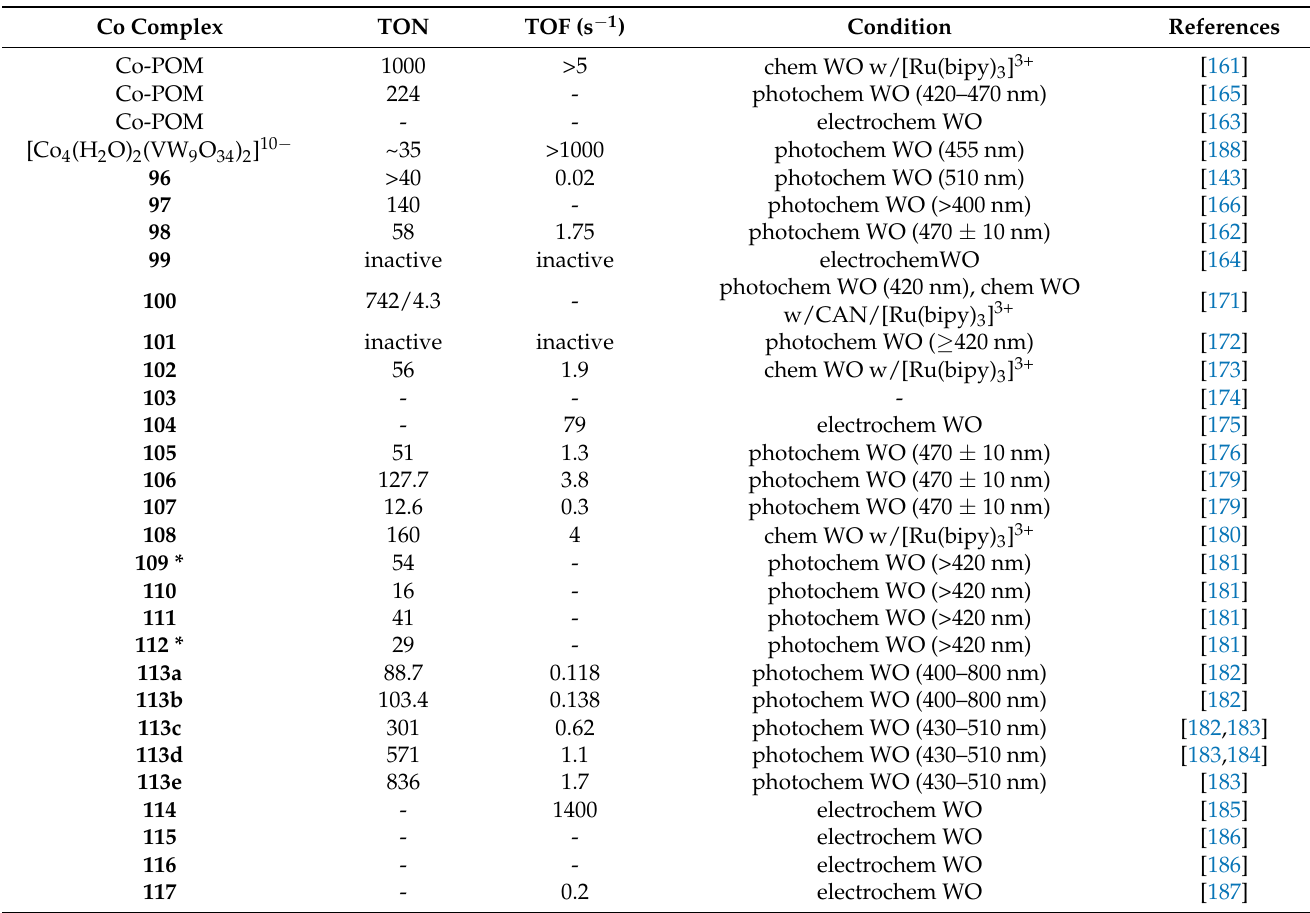
Table 7. Selected catalytic parameters and experimental conditions for Co catalysts 96–117 for water oxidation. Photochemi- cal, electrochemical, and chemical water oxidation are abbreviated as ‘photochem WO’, ‘electrochem WO’, and ‘chem WO’, respectively. The TON or TOF values that are not listed in this table are unavailable in literature. Irradiation wavelength for photochemical WO is in